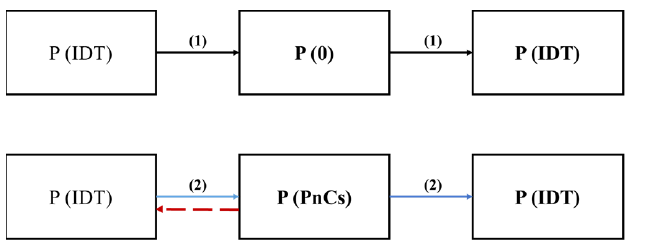
Figure 8. The P matrix equivalent models of delay line structures with and without micro PnCs. In Figure 8, transmitting path 1 (cid:13) indicates that the signal transmits from the emitting IDT to the receiving IDT across the free surface, which can be expressed by the following Equation: where Y 210 is the first signal in the transfer admittance of the Love wave mode delay line with the common waveguide layer transmitting path and P 210 is the transmission coefficient of the common waveguide layer transmitting